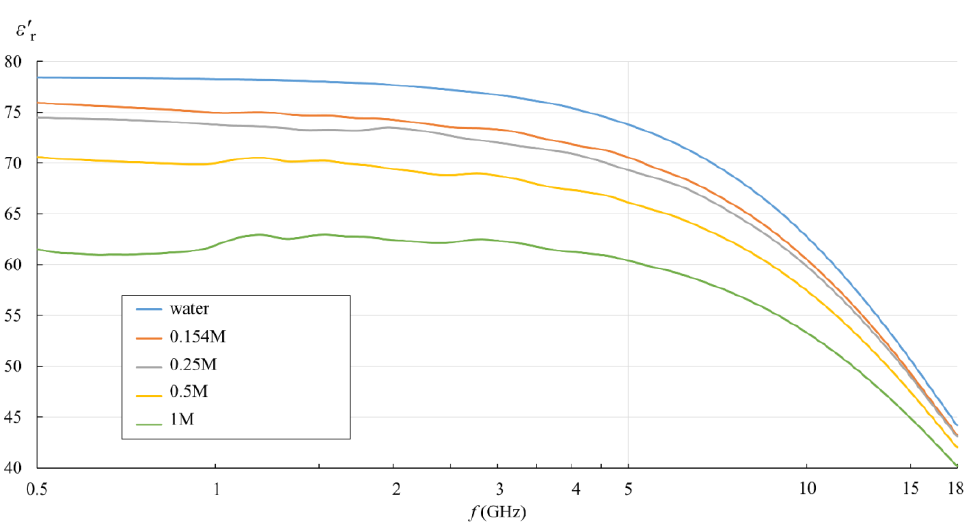
Figure 5. Measured ε (cid:48) r of water and saline solutions, as obtained from the measurement software Figure 5. Measured 𝜀 r′ of water and saline solutions, as obtained from the measurement software (frequency in logarithmic (frequency in logarithmic scale).